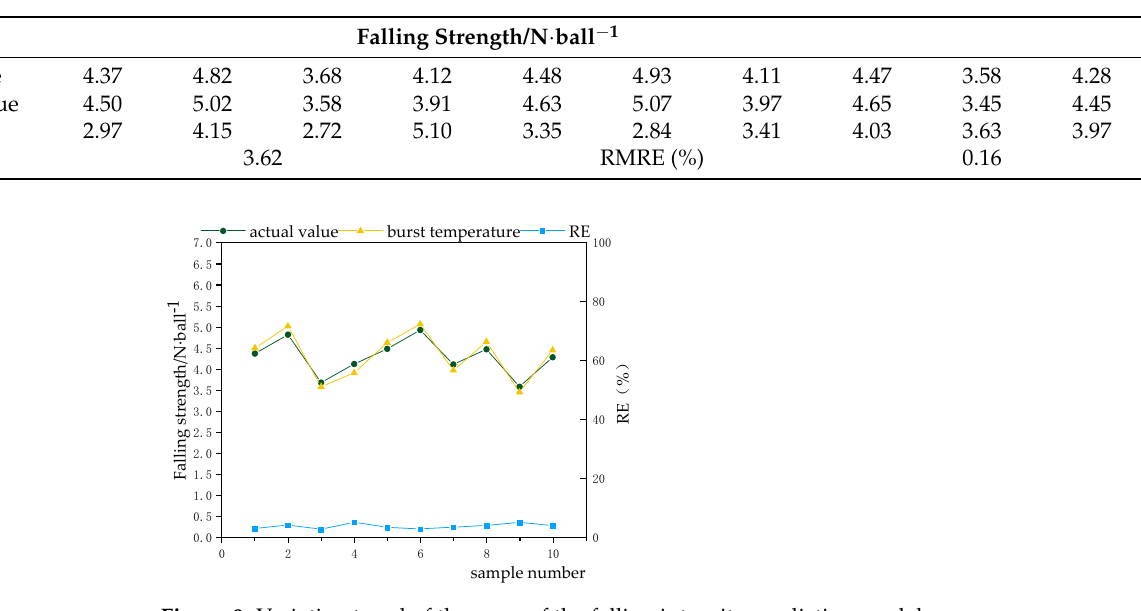
Table 11. Comparison of falling strength prediction results.